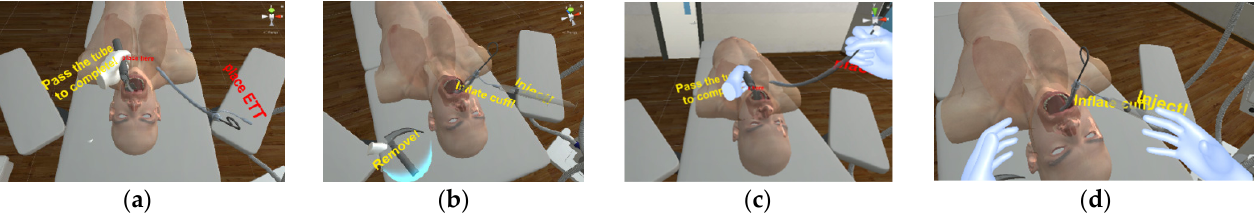
Figure 5. The scene of laryngoscope insertion and inflate cuff: ( a ) laryngoscope insertion with controller; ( b ) remove laryngoscope; ( c ) laryngoscope insertion with hand; ( d ) inflate cuff with hand.